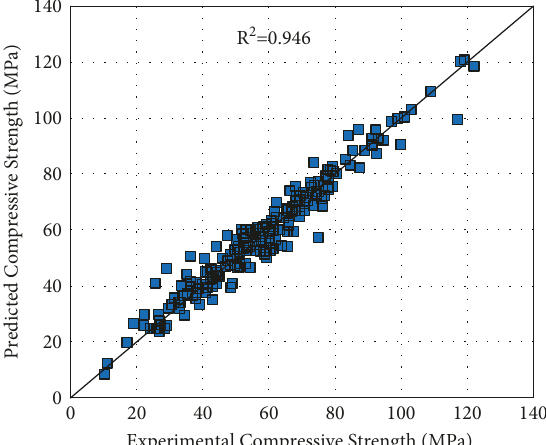
Figure 9: Experimental vs. forecasted compressive strengths for ANN-TLBO-1L (8) model for all